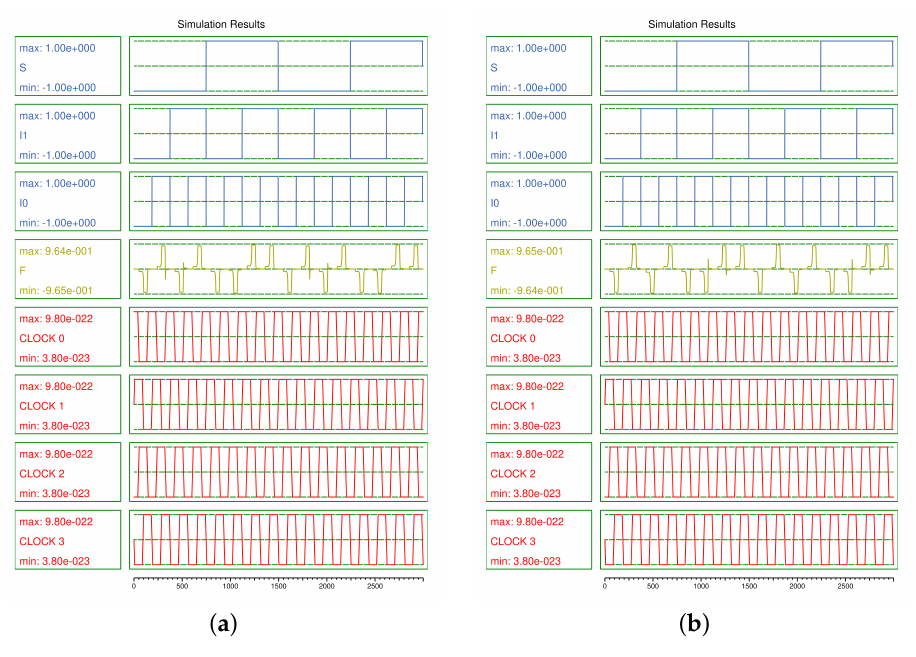
Figure 5. Simulation results of the proposed 2 × 1 MUXes: ( a ) MUX1; ( b ) MUX2. The comparison of energy dissipation of the proposed MUX designs with other existing MUX designs are shown in Table 3. The average energy is calculated by taking the average of the result of all the different input